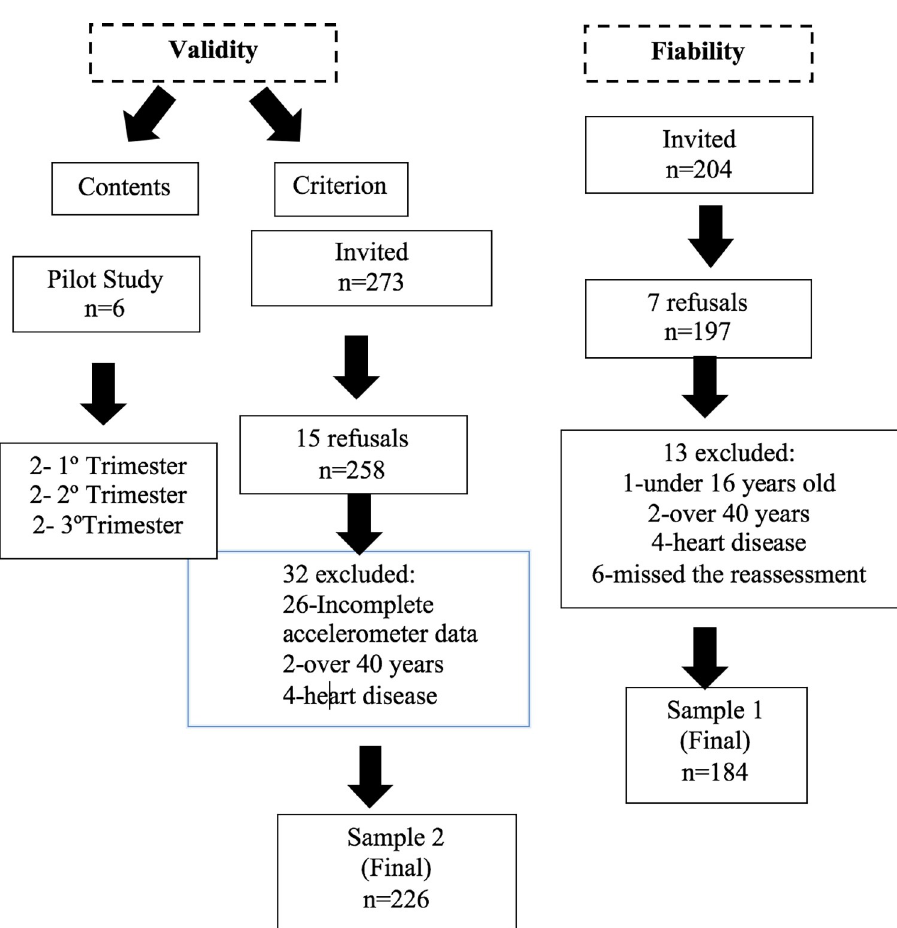
Fig 1. Flowchart of samples for content validity, criterion validity and